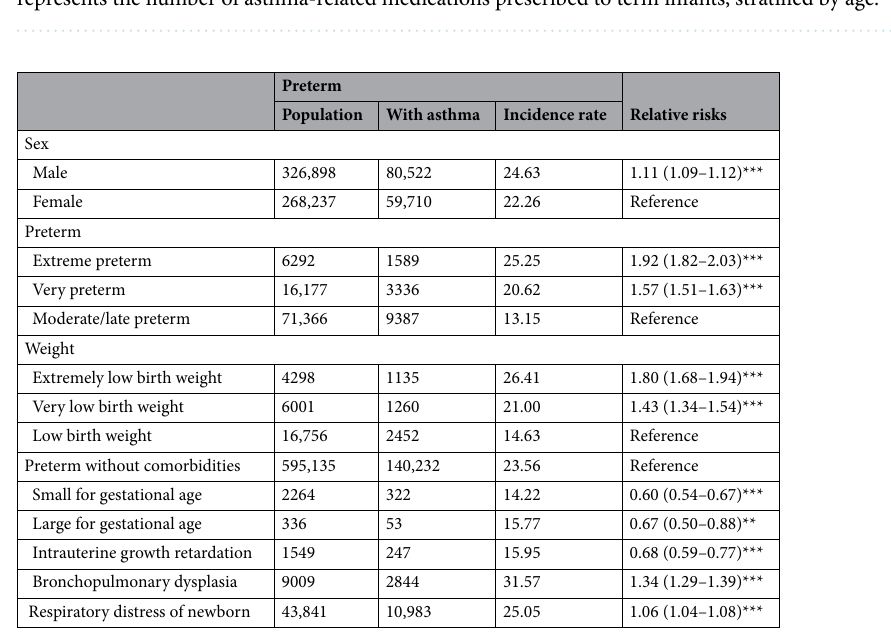
Table 2. Asthma-related drug prescription rates per person diagnosed with asthma and risk factors in preterm infants. * p < .05; ** p < .01; *** p < .001.